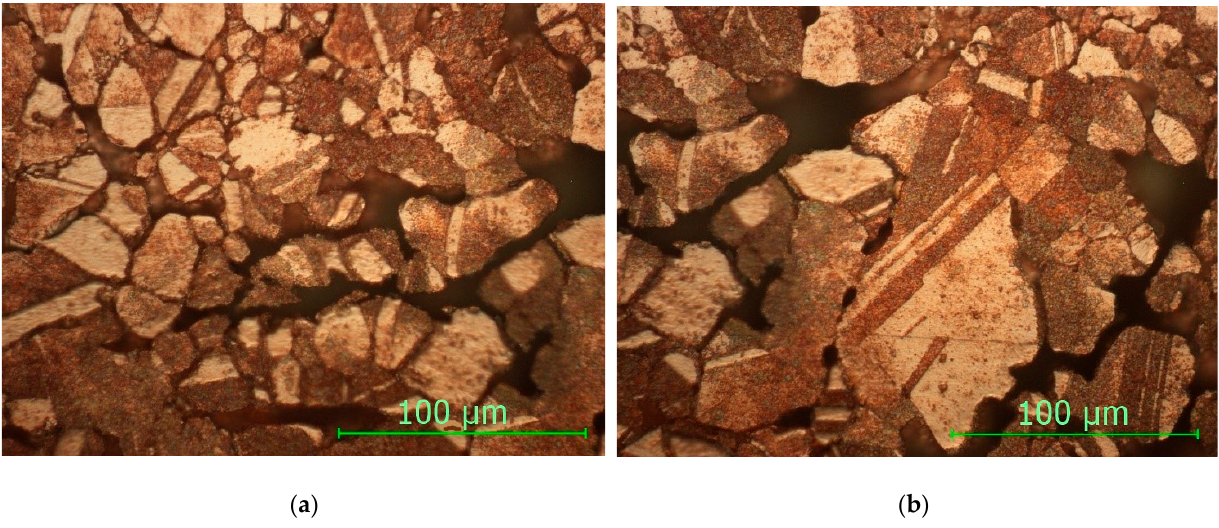
Figure 9. Sample SFW900: ( a ) upper side; ( b ) bottom side (magnification 500×).